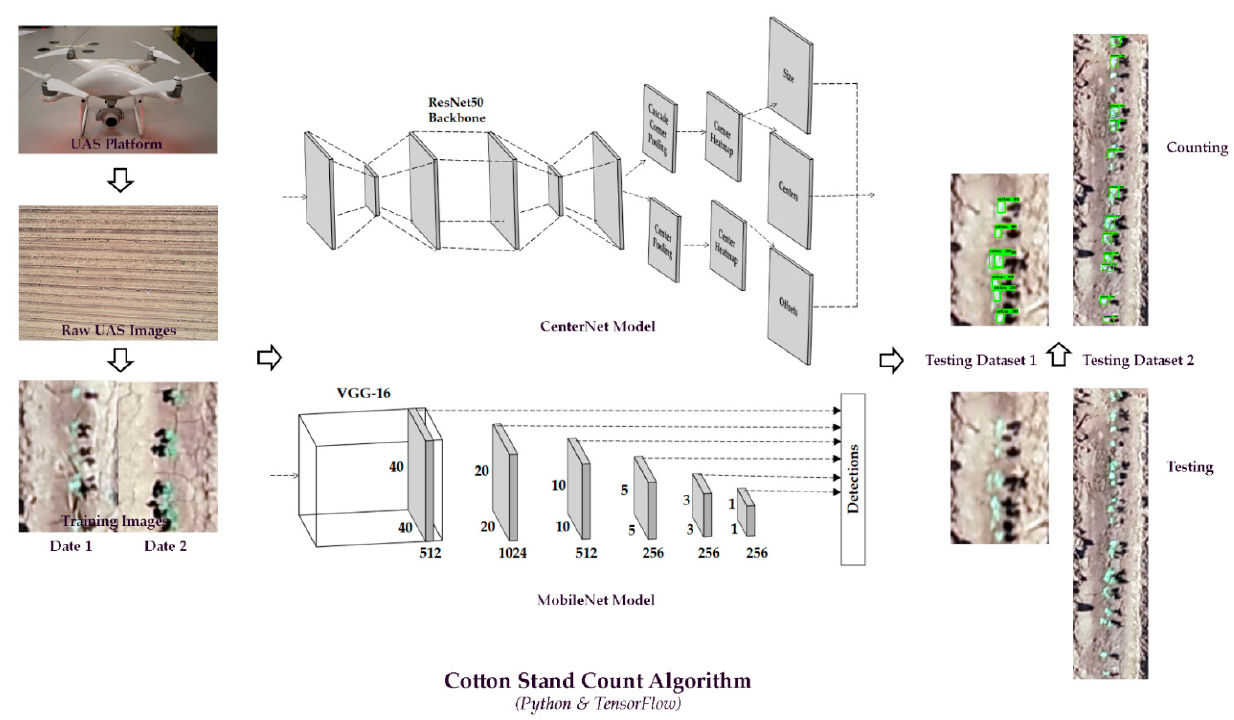
Figure 1. Cotton stand count using CenterNet and MobileNet machine learning algorithms based on unmanned aerial system images.